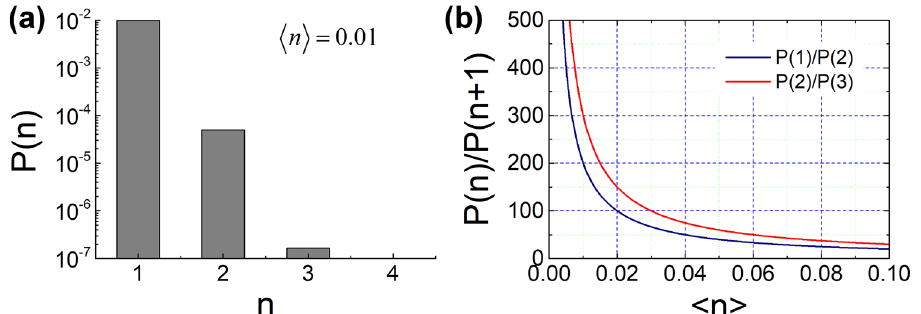
Figure 2. ( a ) Photon-number distribution P ( n ) of coherent light as a function of the number of photons with mean photon number